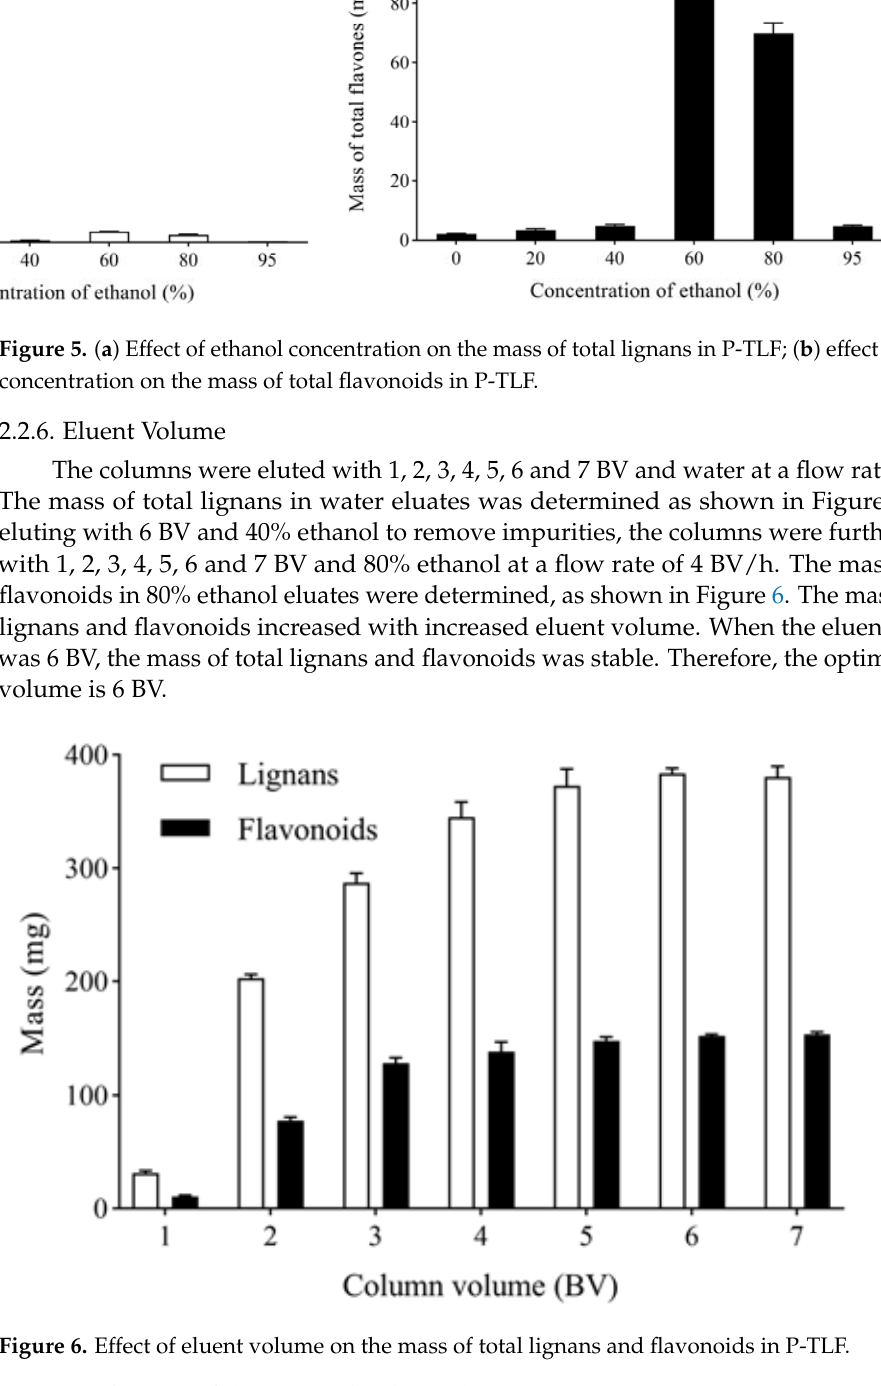
Figure 6. Effect of eluent volume on the mass of total lignans and flavonoids in P ‐ TLF.